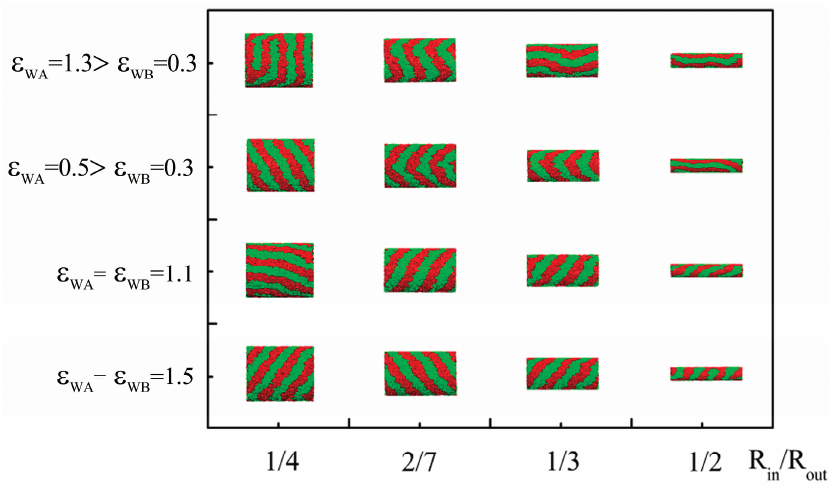
Figure 5. Self-assembled morphologies for multi-walled nanotube confined systems. Morphologies for different wall–polymer